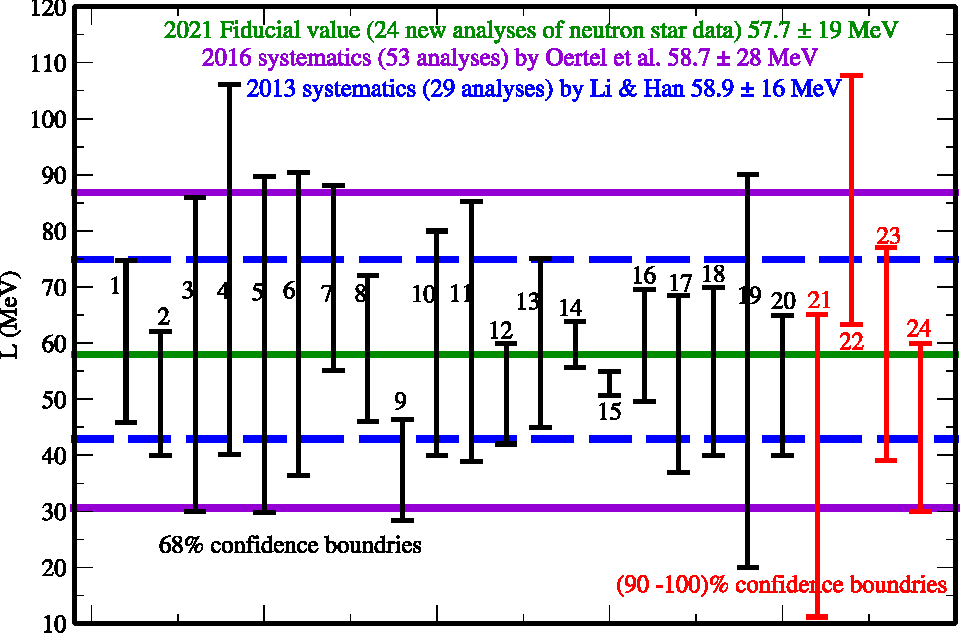
Figure 1. The slope parameter L of nuclear symmetry from the (1) 2013 survey of 29 analyses of terrestrial experiments and astrophysical observations (between the dashed blue lines) [61], (2) 2016 surveys of 53 analyses (between the violet lines) [9], and (3) 24 new analyses of neutron star observables since GW170817 (see the detailed list in the text). The green line is the average value of L from these 24 new